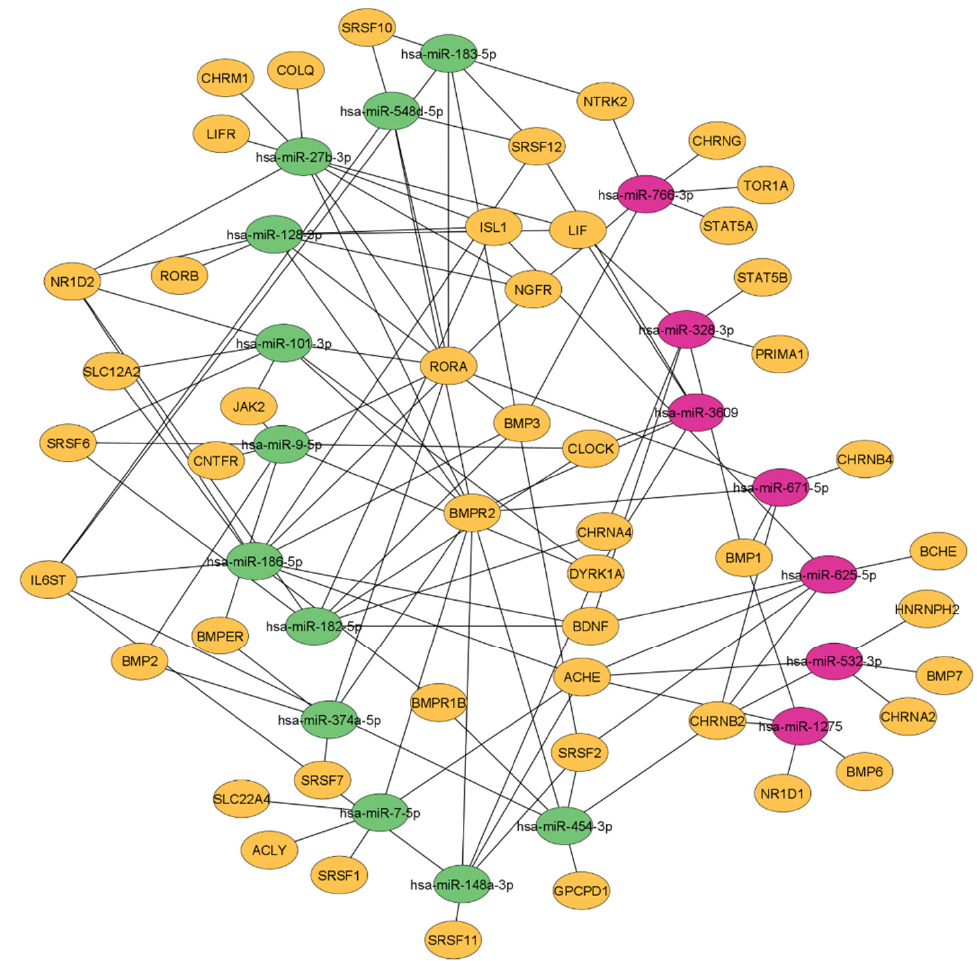
Figure 6. miR-gene interactions. Up-(green) and downregulated (magenta) FMS CholinomiRs are connected to their respective cholinergic target genes (orange) with a total of 47 targets. See comprehensive interaction summary with complete gene names in Supplementary File S2. Abbreviations: miR, microRNA.